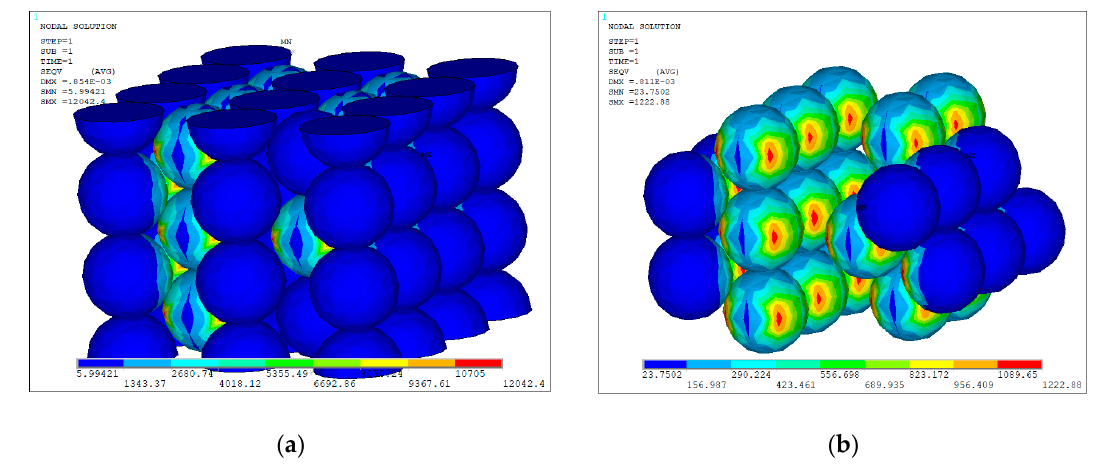
Figure 6. Stress contours of 5 layer GO reinforced Al composite: ( a ) 5 layered GO / Al; ( b ) Corresponding Al particles.